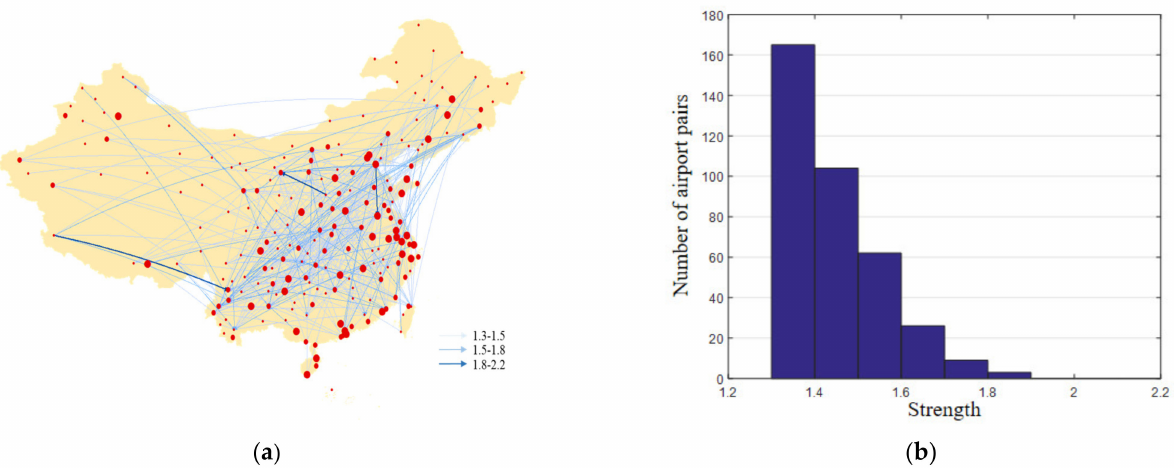
Figure 14. Delayed propagation causality network with in-degree greater than 10. ( a ) Causality network ( b ) Number of airport pairs with different strength.